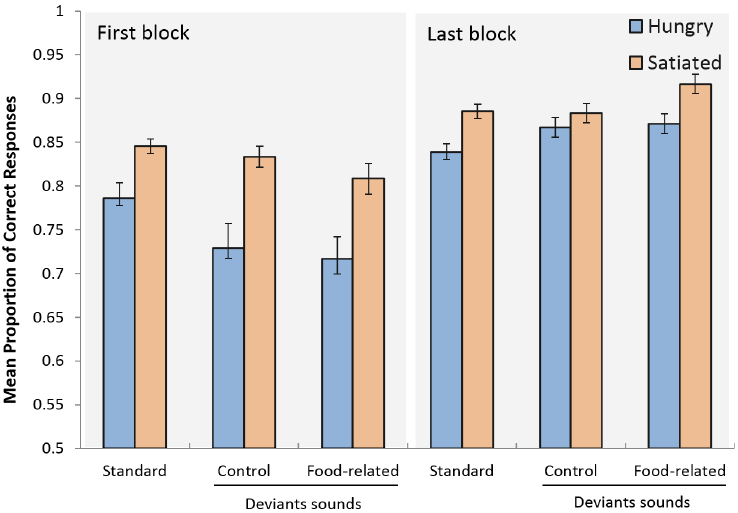
Fig 1. Mean proportion of correctresponses as a function of the sound conditions, block and group. Error bars represent one standarderror of the mean.